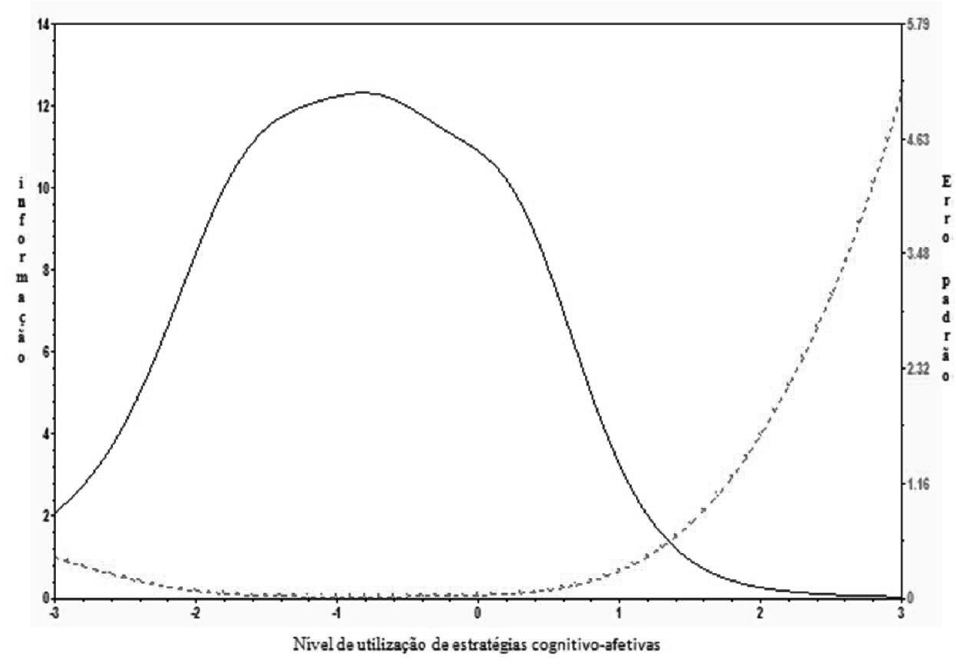
Figura 2 . Curvas de informação e de erro da medida (MRG) da Escala de Estratégias Cognitivo-afetivas de Aplicação do Aprendido no